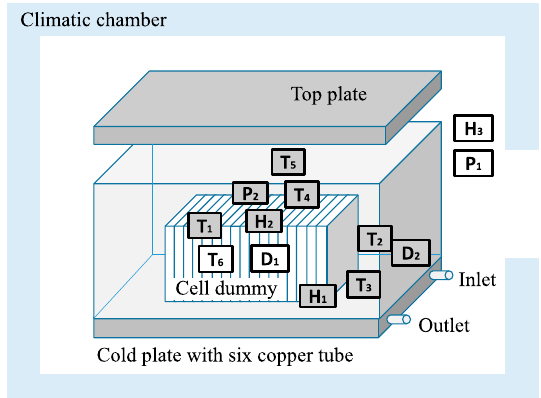
Figure 3. Position and mounting of the sensors inside the battery system: T 1 to T 5 : temperature sensors in the housing, T 6 : temperature sensor on the outside front wall, H 1 : humidity sensor at cold plate, H 2 : humidity sensor at the simulated cells, H 3 : humidity sensor on the climatic chamber, P 1 : pressure sensor on the climatic chamber, P 2 : pressure sensor in the housing, D 1 : dew sensor on the front wall in outside, D 2 : dew sensor on the cold plate next to the inlet of the housing.